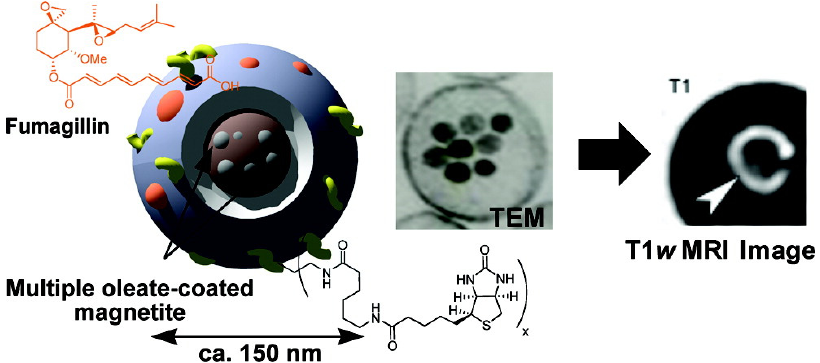
Figure 9. Fibrin-specific IONPs for the T1-weighted imaging of fibrin in atherosclerotic plaque. Reproduced with permission from [178]. Copyright 2009, American Chemical